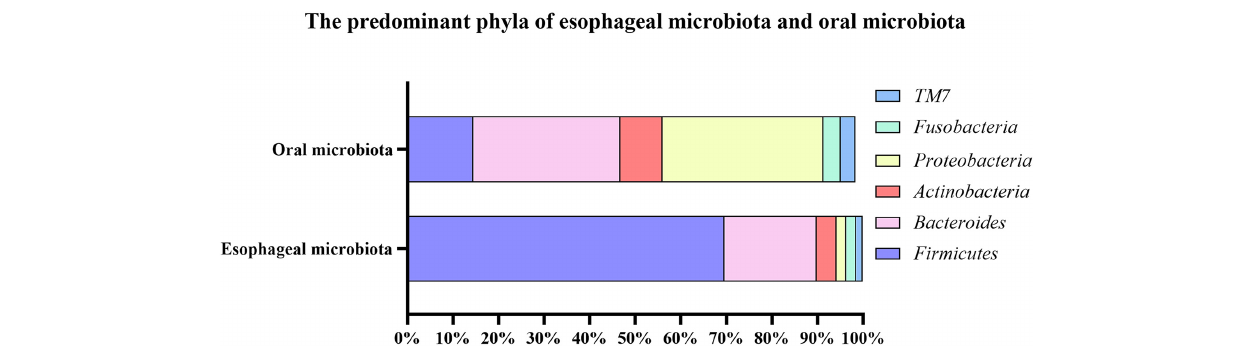
FIGURE 1 | The predominant phyla of esophageal microbiota and oral microbiota. The top six most abundant phyla of esophageal microbiota consisted of Firmicutes (69.60%), Bacteroides (20.20%), Actinobacteria (4.30%), Proteobacteria (2.20%), Fusobacteria (2.20%), TM7 (1.40%); And the top six most abundant phyla of oral microbiota consisted of Proteobacteria (35.34%), Bacteroides (32.20%), Firmicutes (14.48%), Actinobacteria (9.26%), Fusobacteria (3.76%), TM7